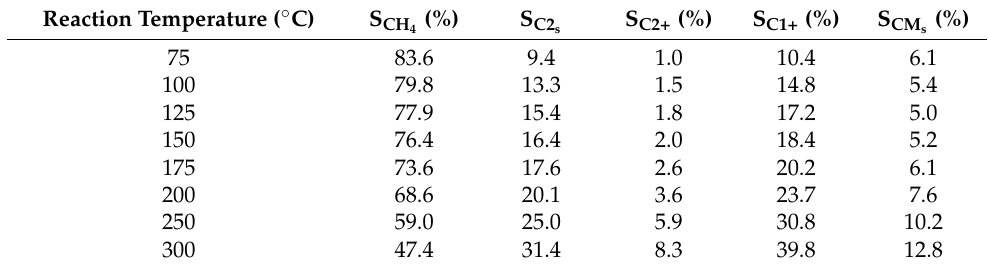
), C 2 hydrocarbons (S C2 ), hydrocarbons with more than two s 4 ) for DS-Pd. s